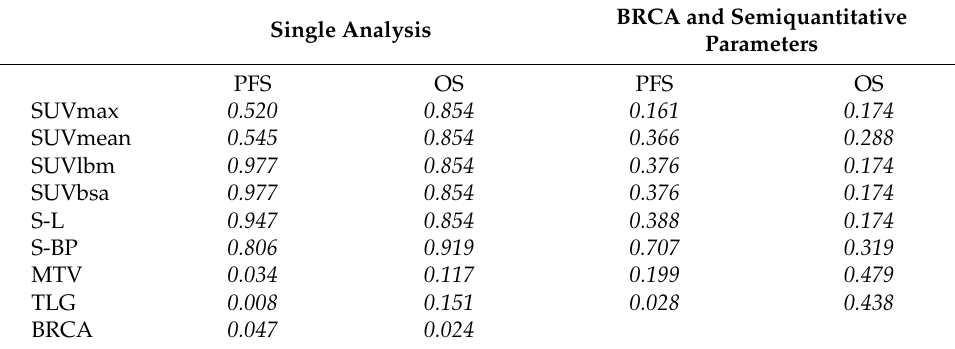
Table 4. Kaplan–Meier results ( p -value) for PFS and OS.